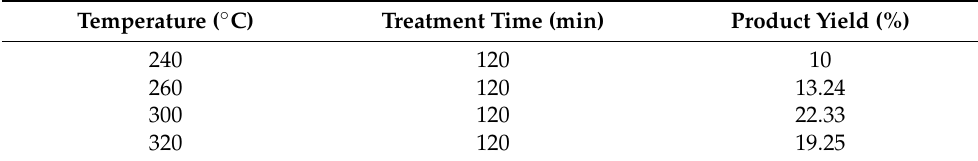
Table 2. Product yield of GQDs at different treatment times and at a constant temperature of 300 °C.